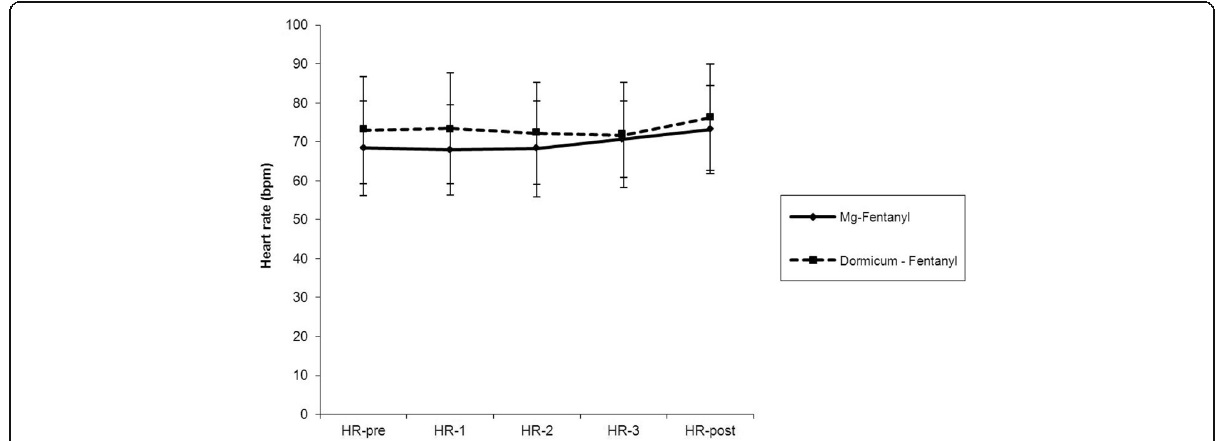
Fig. 1 Heart rate changes in both study groups. Markers represent means and error bars represent 95% C I